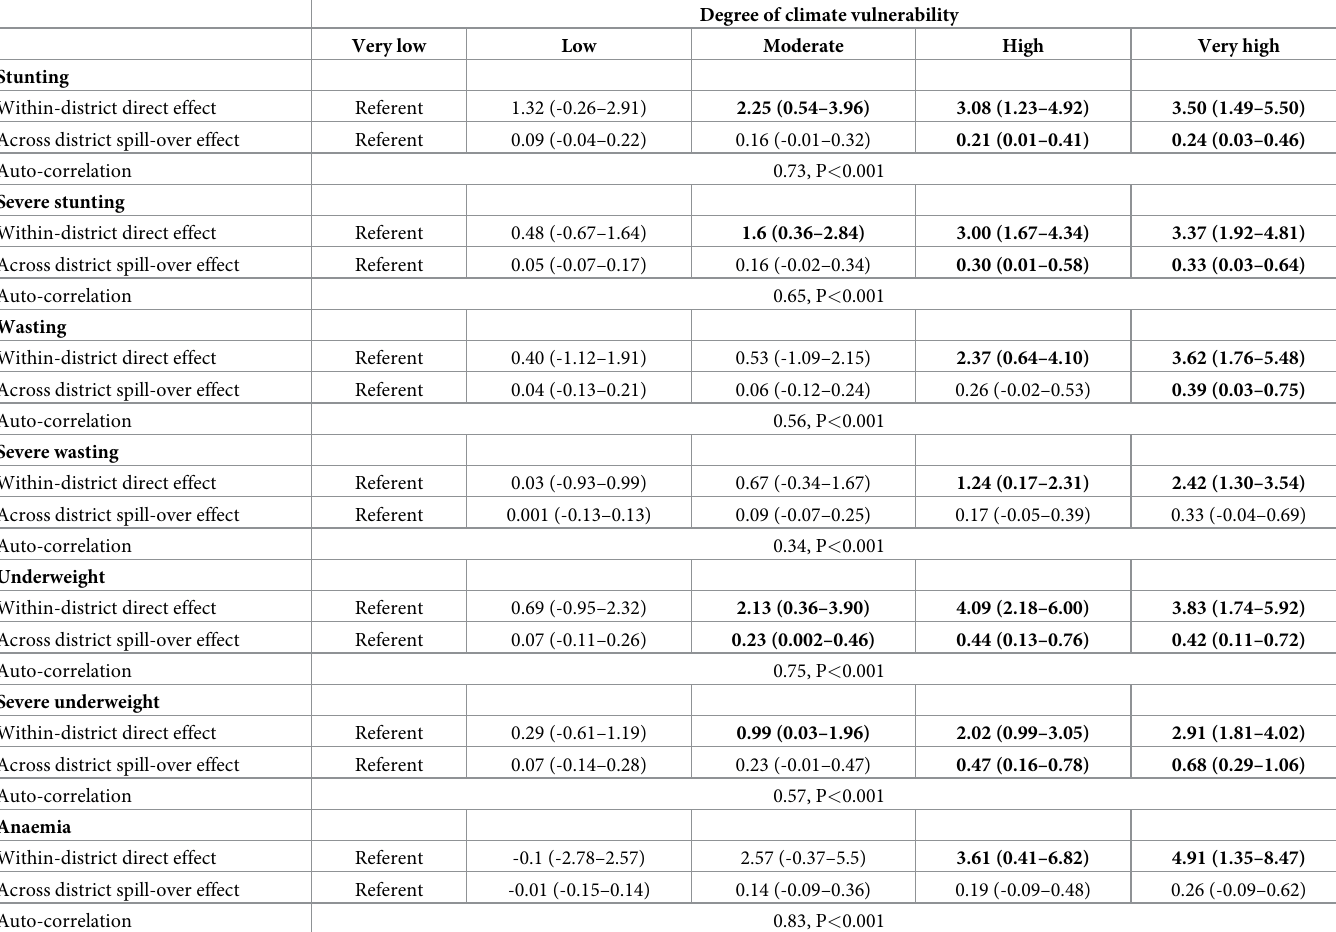
Table 4. Expected percentage gain/reduction in nutritional status of children within and across districts by degree of vulnerability estimated using spatial autore- gressive